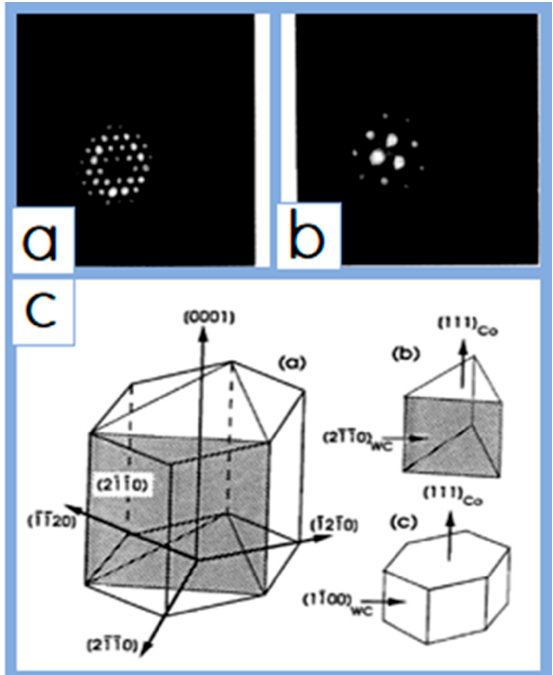
Figure 8. Electron diffraction analysis for nanostructured WC-6%Co-0.8%VC following 8 hr heat- treatment at 700 °C. Micro–micro diffraction patterns for ( a ) (0001) zone axis of matrix, ( b ) (111) zone axis of fee Co nanoprecipitate. ( c ) (a) the Co nanoprecipitate morphology with reference to the hexagonal WC unit cell, (b) and (c) the triangular and hexagonal forms, as deduced from the electronic microscopy observations. Reprinted from Ref. [99] with permission from Nanostruct. Mater.